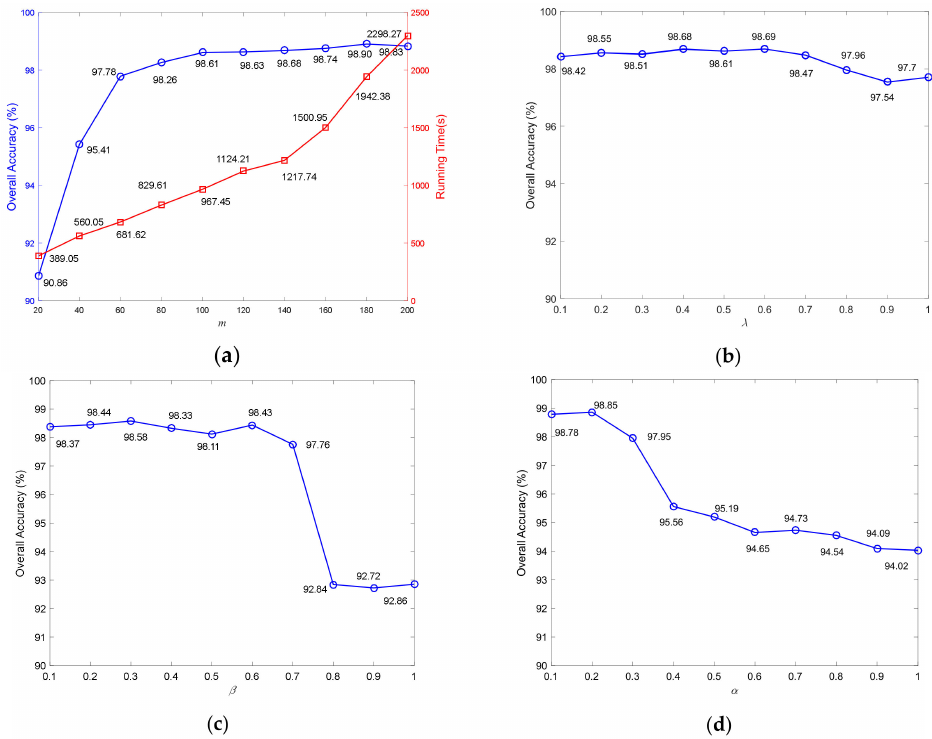
Figure 11. Influence analysis of di ff erent model parameters. ( a ) m ; ( b ) λ ; ( c ) β ; ( d ) α .